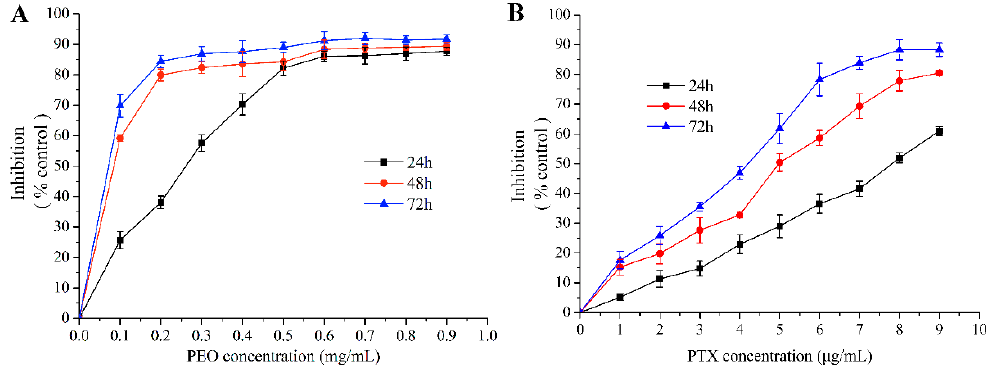
Figure 2. Cytotoxic effects of PEO on MGC-803 cells by MTT assay for 24, 48, and 72 h.